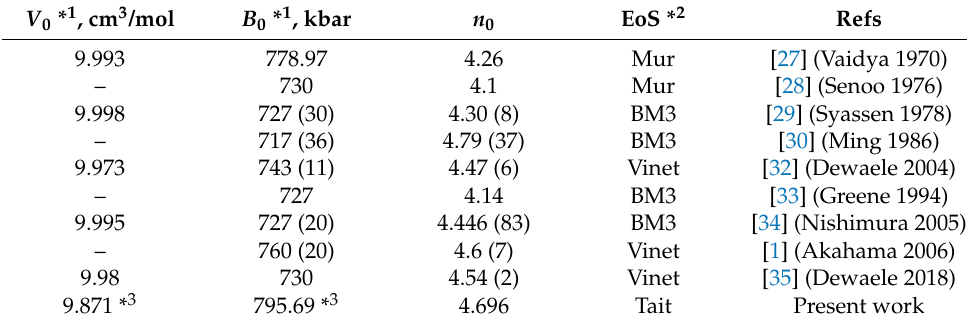
Figure 5. The adiabatic bulk modulus of aluminum plotted against pressure. The temperature-dependent density of liquid aluminum is depicted in Figure 6. The Table 5. Equation of state parameters for calculated density of 2.373 g/cm 3 for liquid aluminum at the melting temperature is differ- ent by 0.08% from the experimental average.